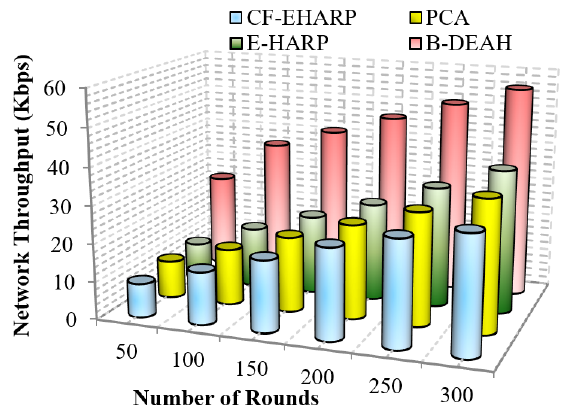
Figure 8. Network throughput vs. simulation rounds (emergency